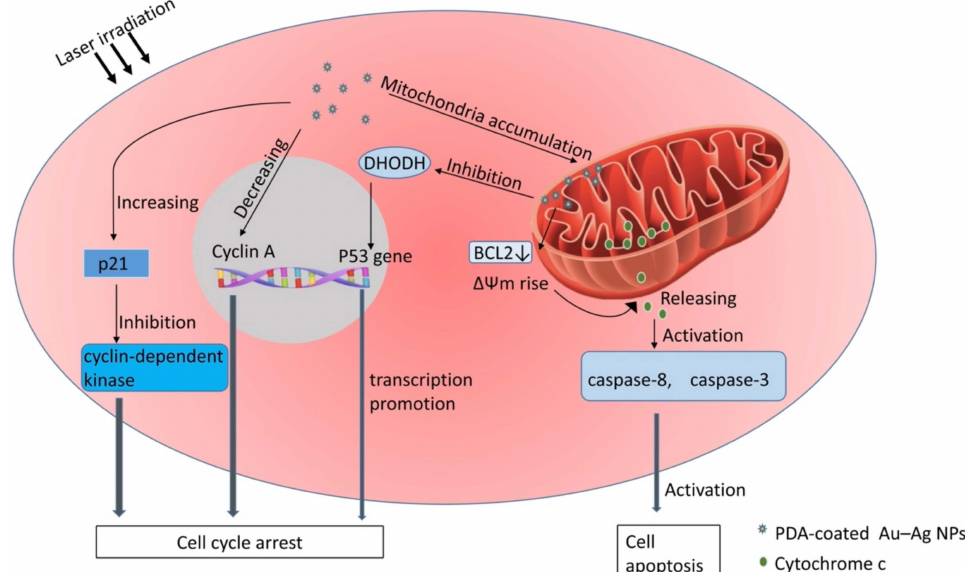
Figure 2. Mechanism of laser-irradiation-induced proliferation arrest and apoptosis of